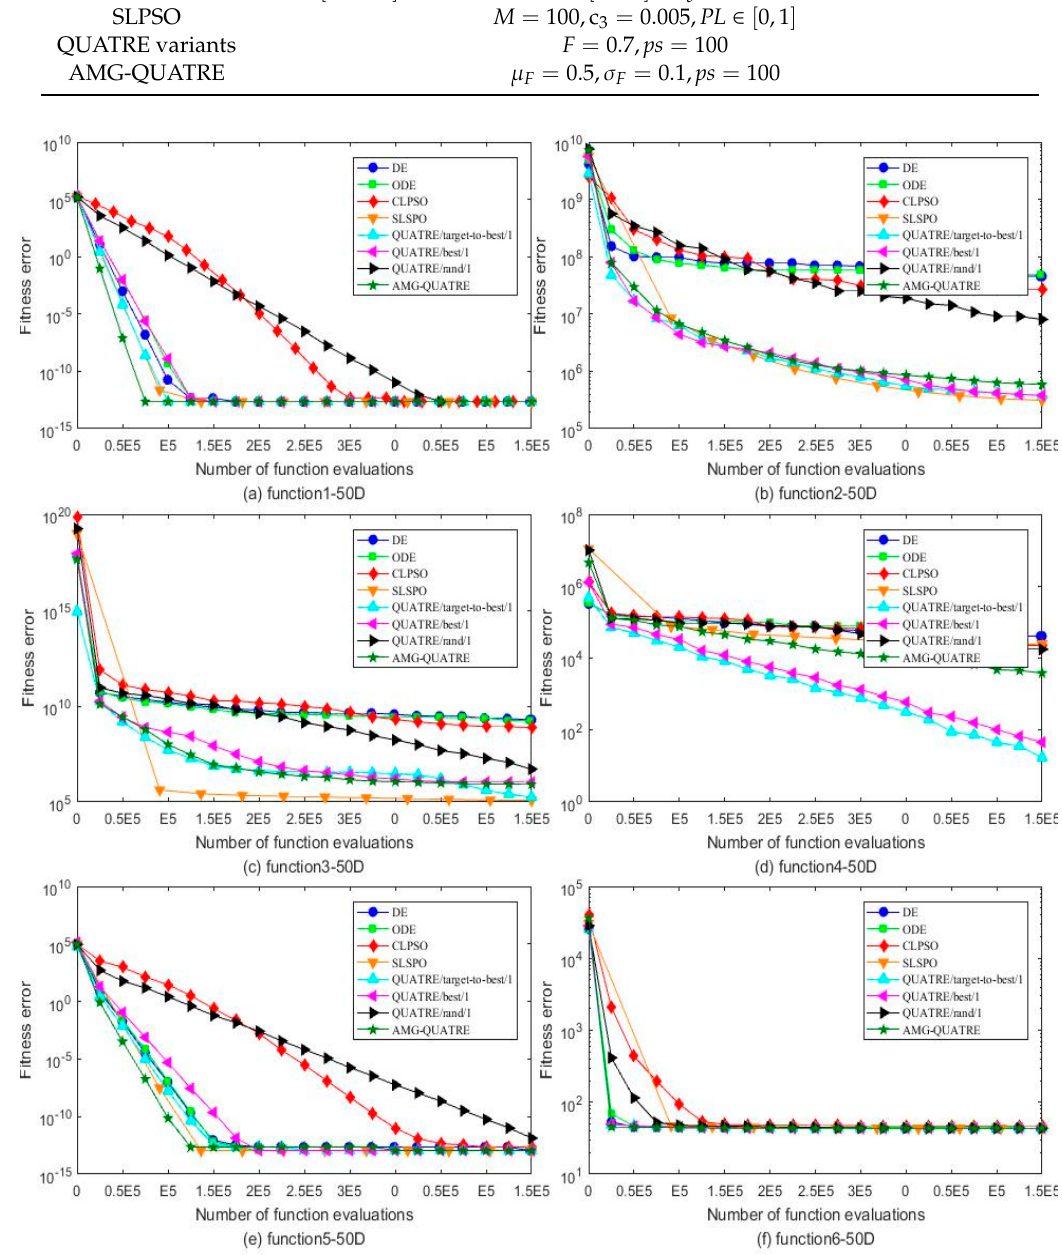
Figure 3. Comparison of the best of fitness errors for functions f 1 – f 6 with 50D optimization. ( a ) f 1 ; ( b ) f 2 ; ( c ) f 3 ; ( d ) f 4 ; ( e ) f 5 ; ( f ) f 6